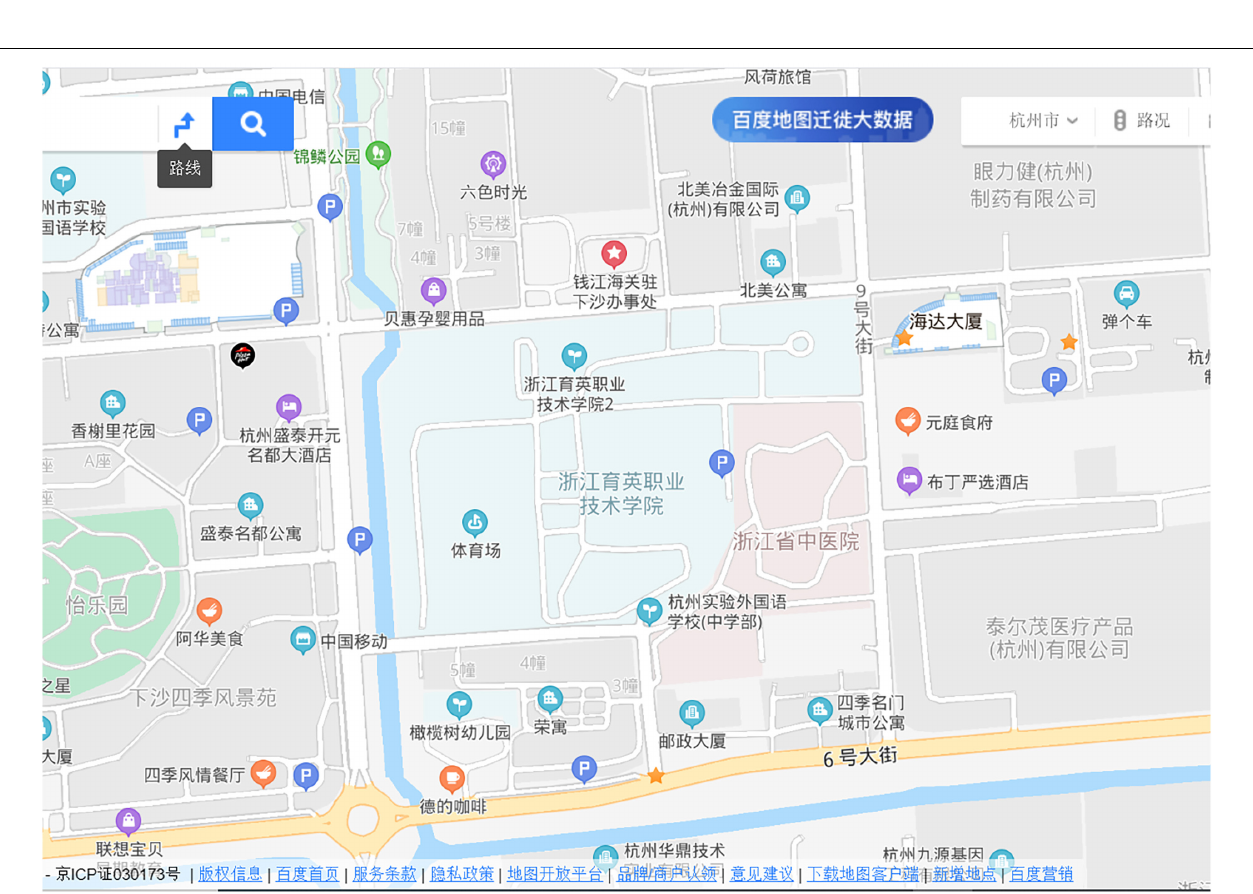
FIGURE 3 | The participants start from the starting point (see Figure 2 ), walk by 16 landmarks and back to the starting point (the ending point).